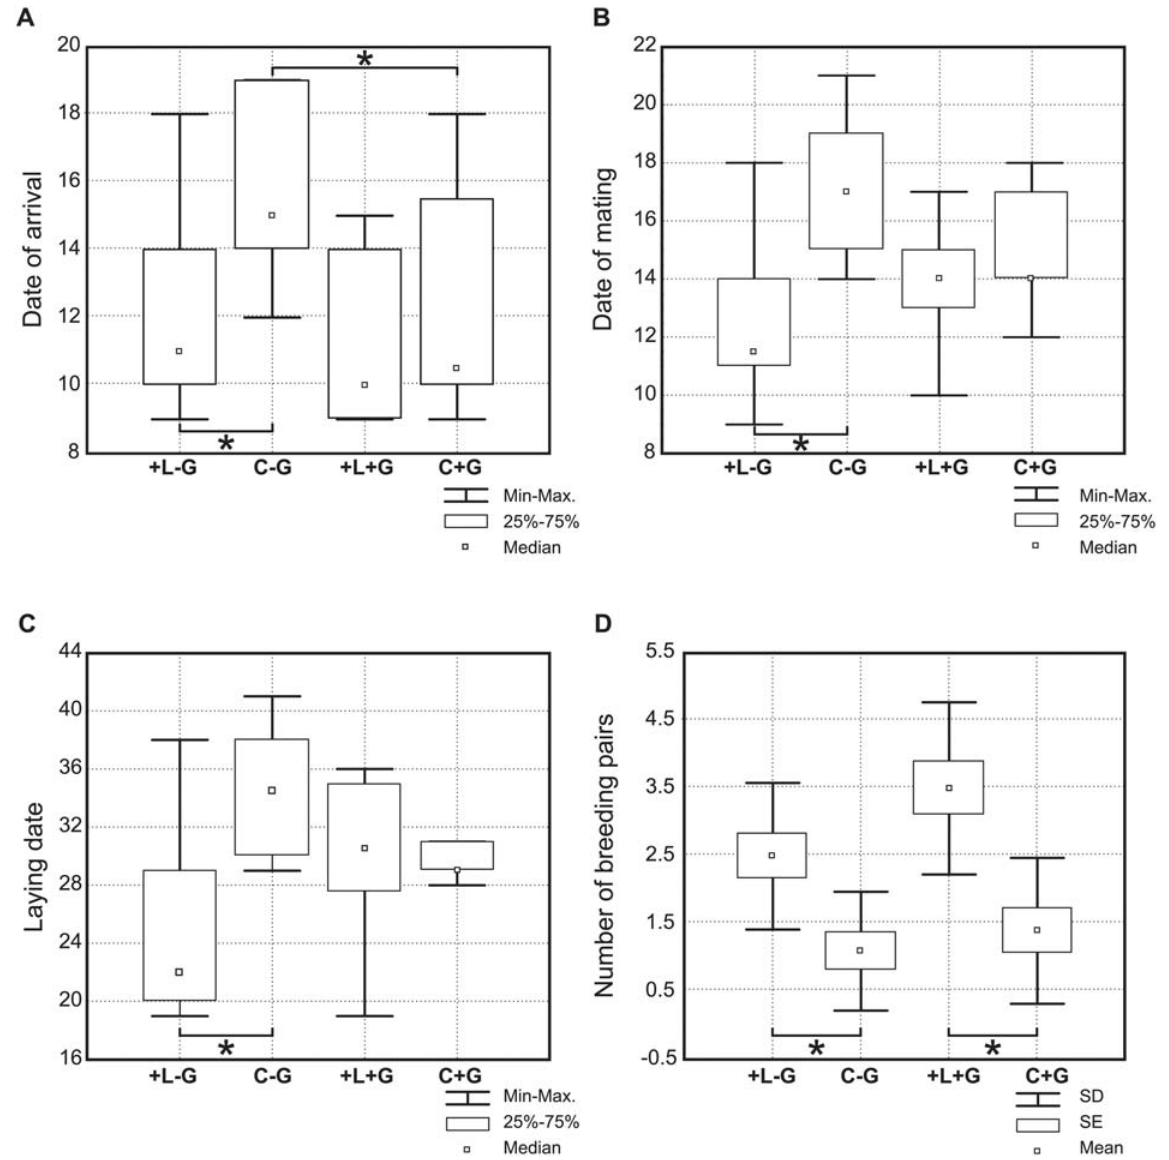
Figure 1. Effect of treatment plots on median a) settling date of male red-backed shrikes (days after May 1 st ), b) pairing date (days after May 1 st ), c) egg laying date (days after May 1 st ) and d) number of red-backed shrike breeding pairs. Significant relationships are marked with asterisks.